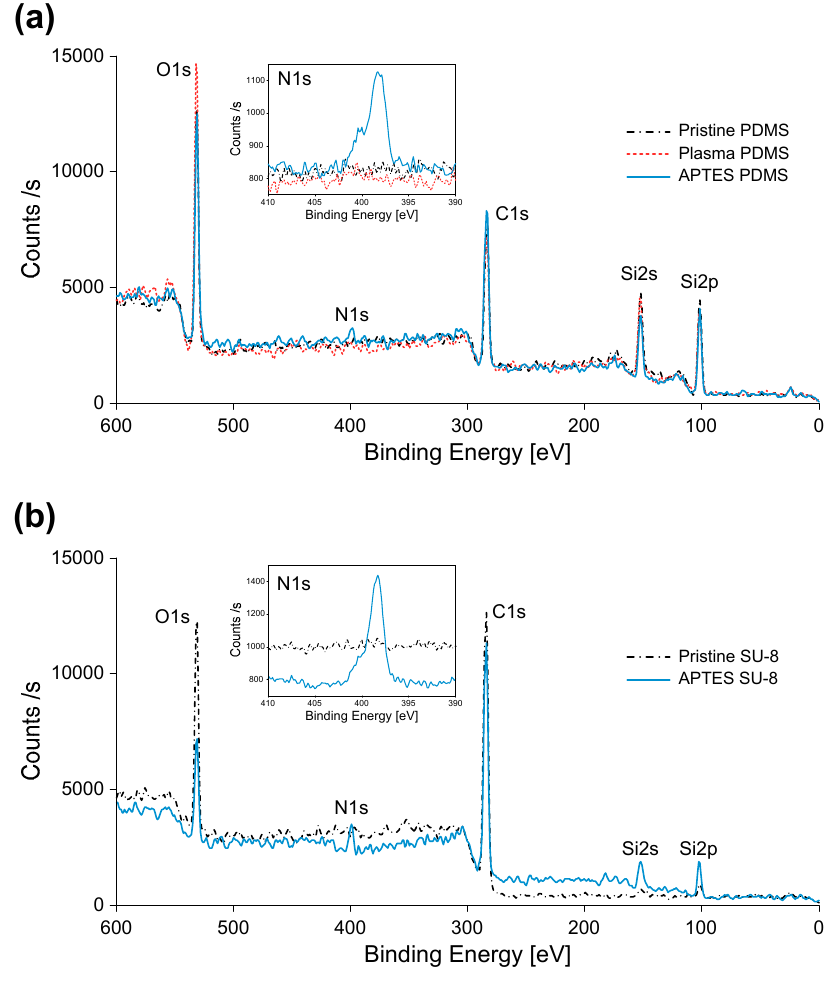
Figure 4. XPS of PDMS and SU-8: ( a ) pristine, plasma-activated, and APTES-modified PDMS; and ( b ) pristine and APTES-modified SU-8.